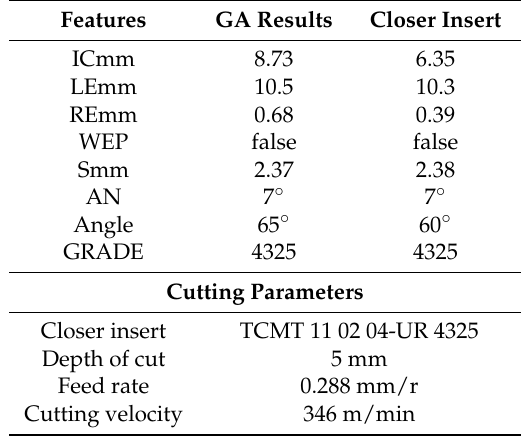
Table 11. Goal variables evaluation for light roughing operation example.